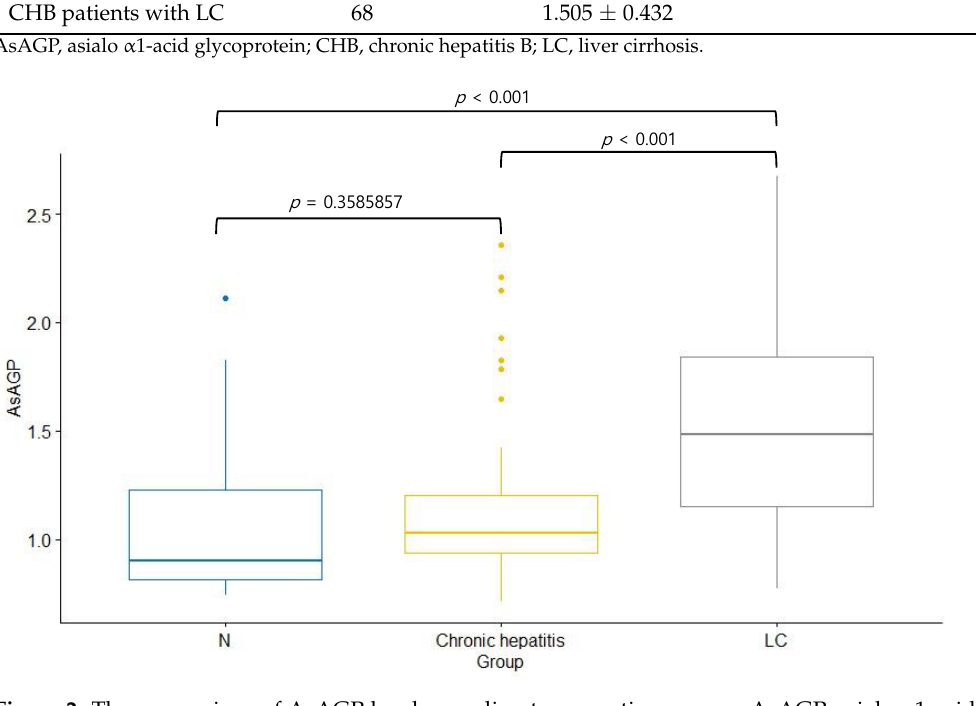
Figure 2. The comparison of AsAGP level according to respective groups. AsAGP, asialo α 1-acid glycoprotein; CHB, chronic hepatitis B; LC, liver cirrhosis.